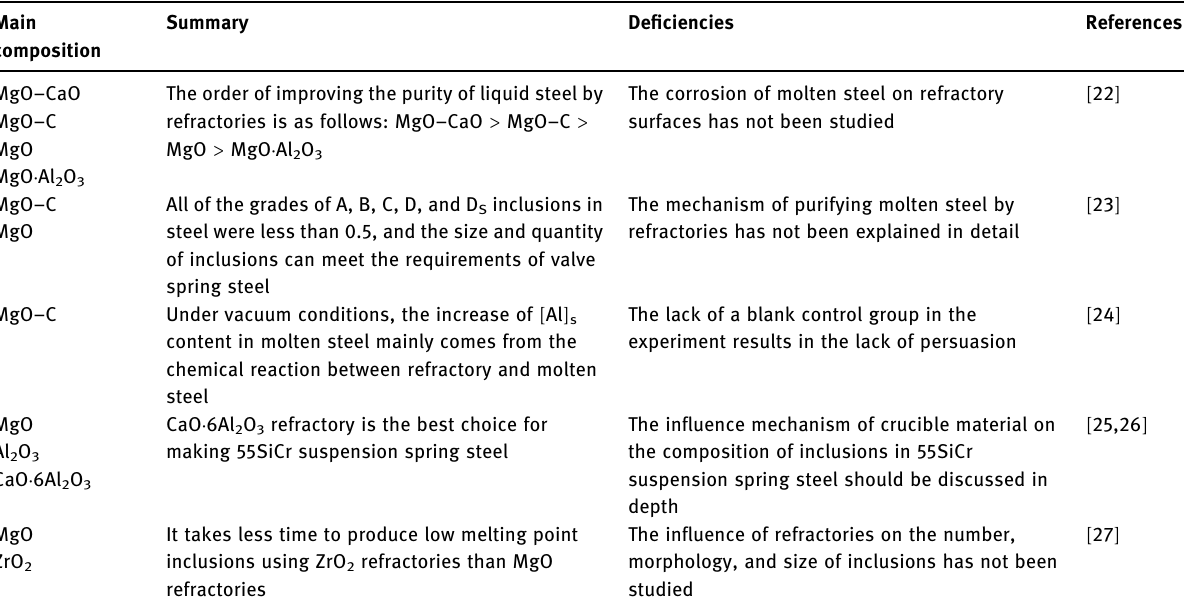
Table 1: Refractories used in the smelting of 55SiCr suspension spring steel in the last decade